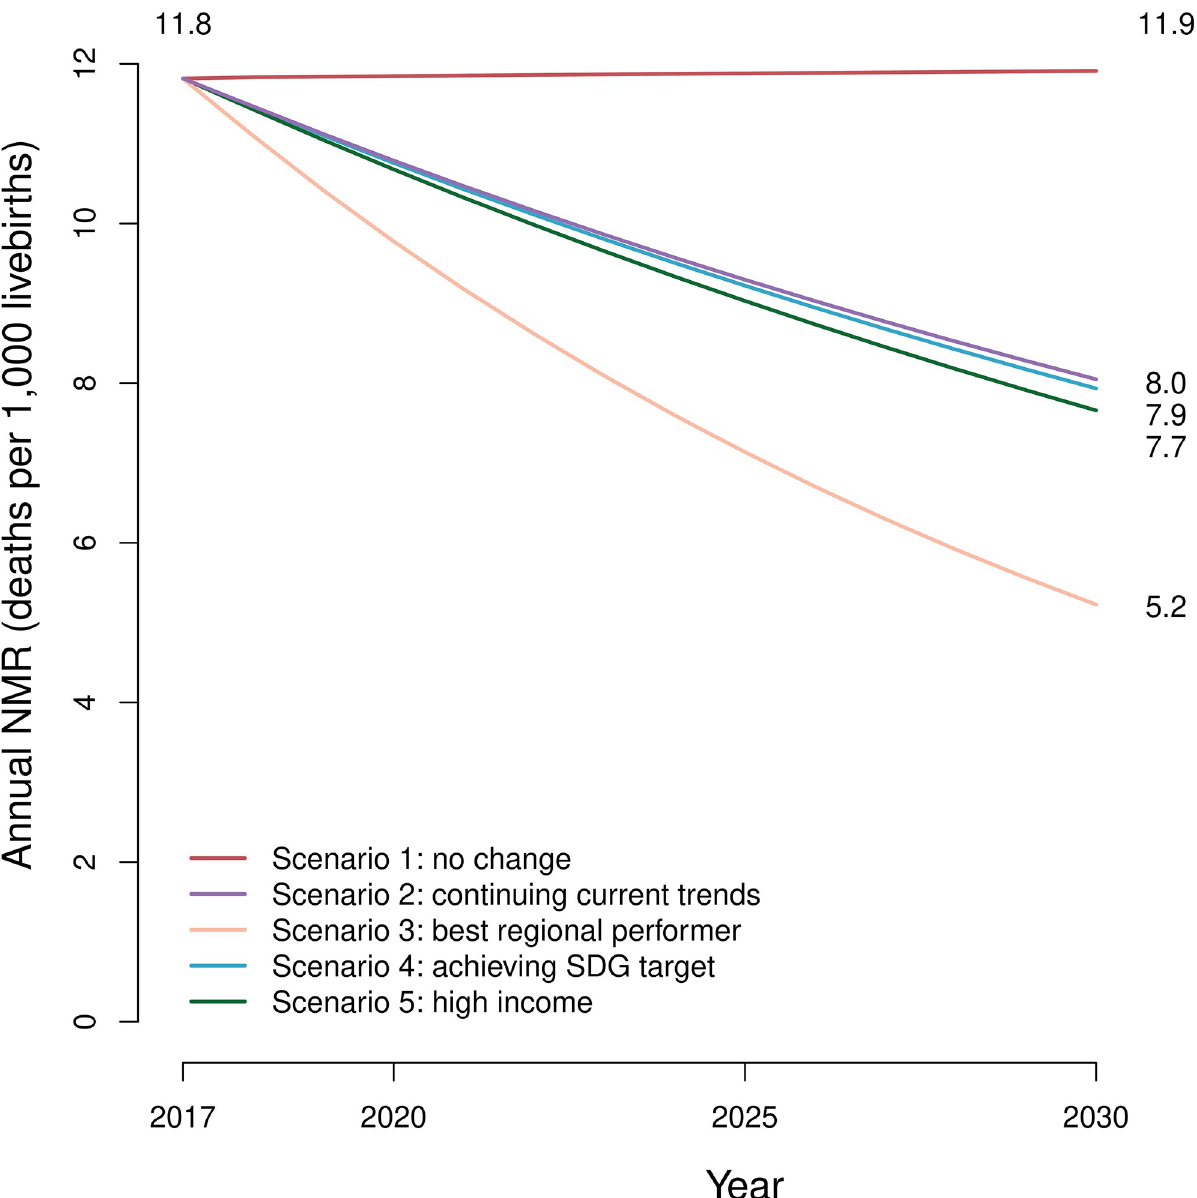
Fig 6. National NMR projection to 2030 based on five